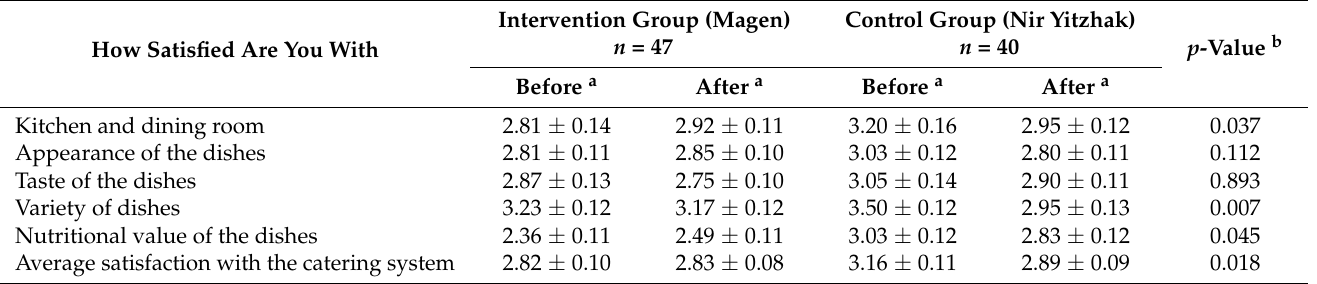
Table 4. Changes in diner satisfaction with the catering service following the